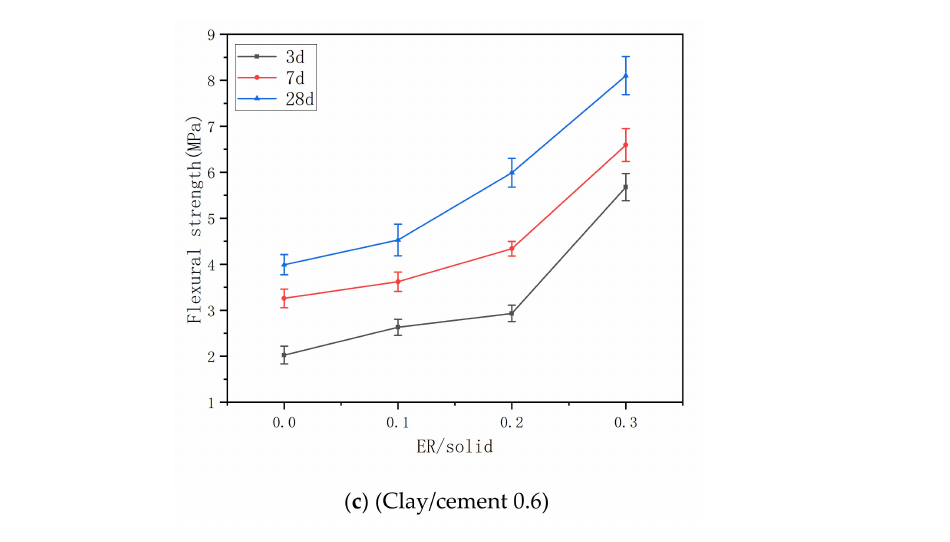
Figure 5. Flexural strength of the grouts with different ER/solid and clay/cement. ( a ) Clay/cement 1.4; ( b ) Clay/cement 1; ( c ) Clay/cement 0.6.